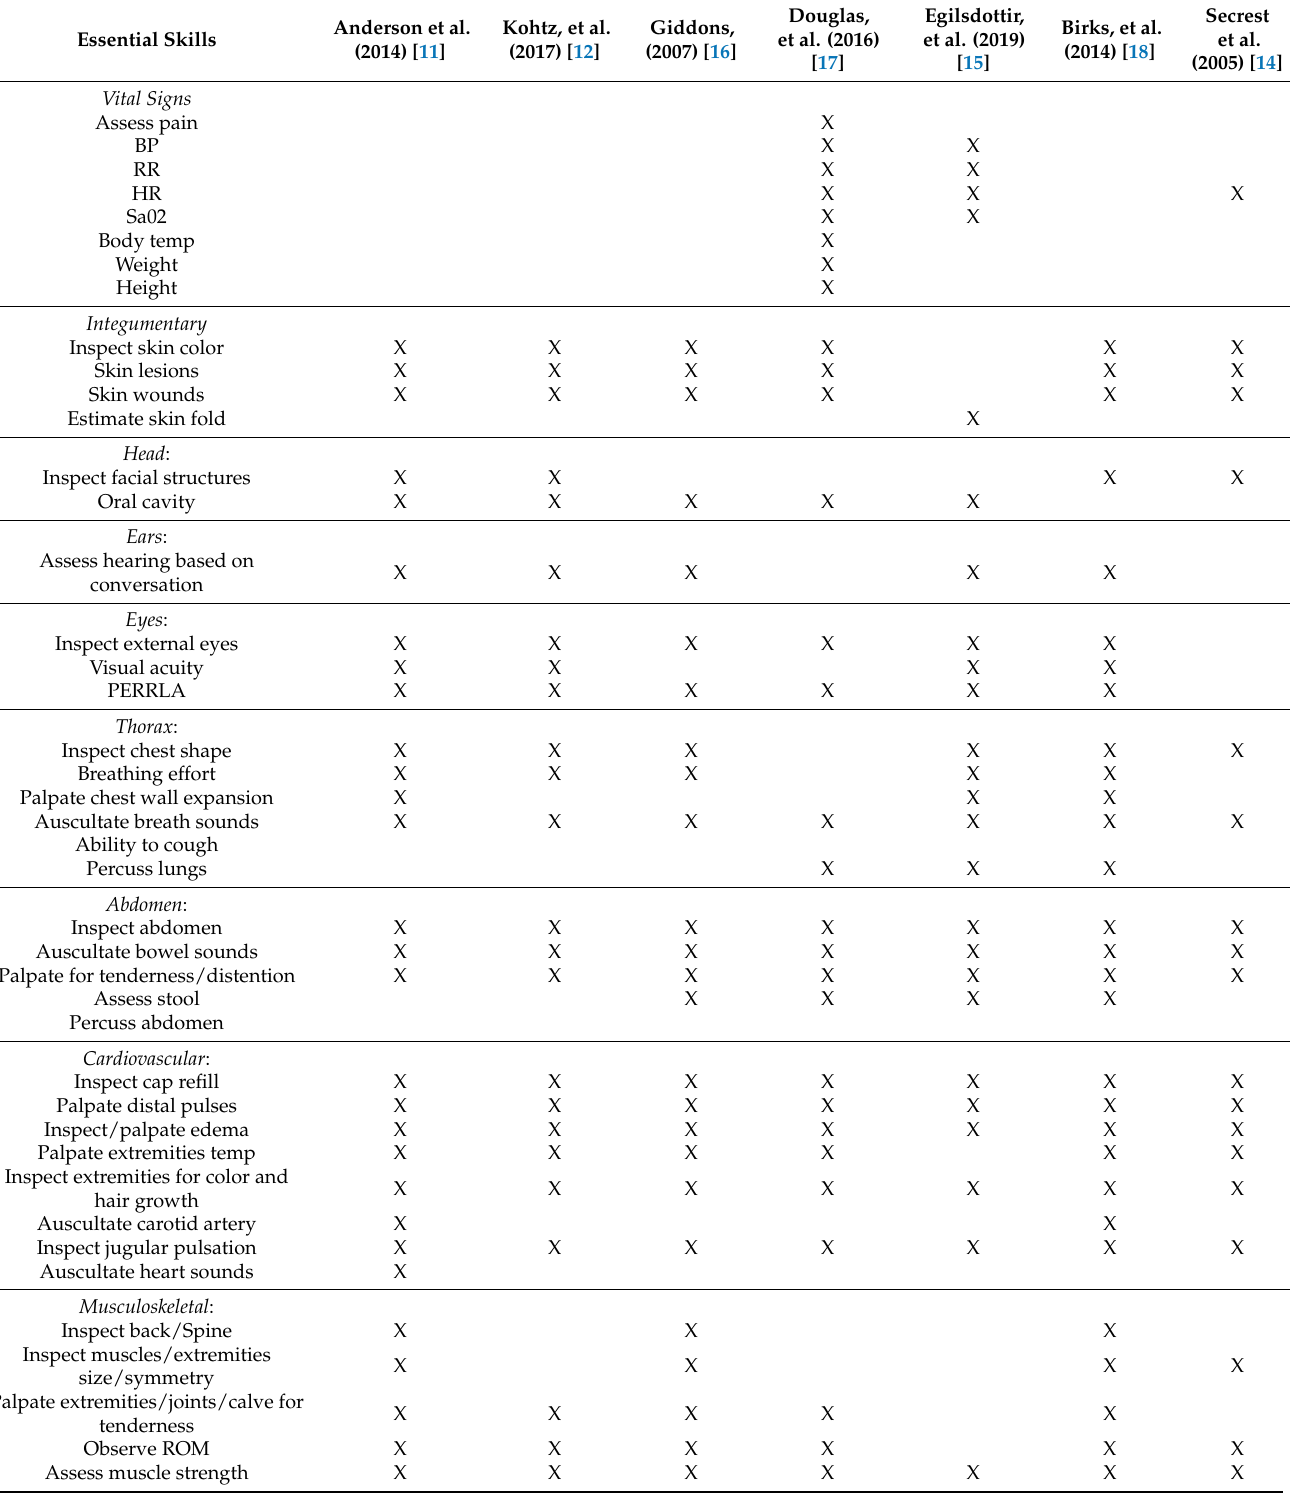
Table 1. Essential Skills Summary